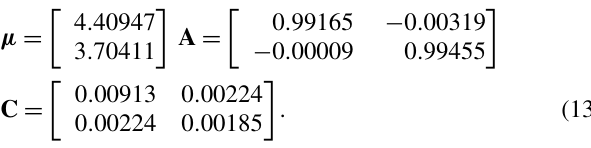
; and AR(1) model for COD r and 4 , S